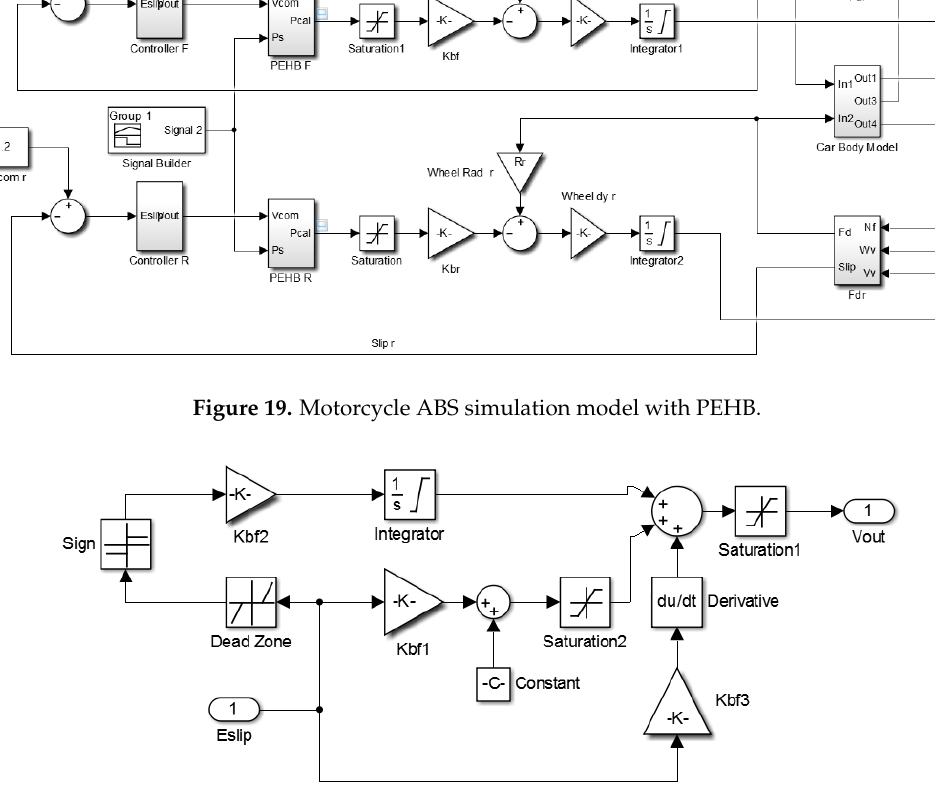
Figure 20. PID controller simulation model.